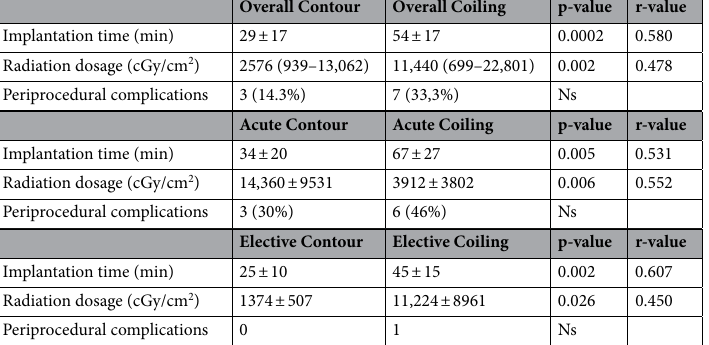
Overall Contour Overall